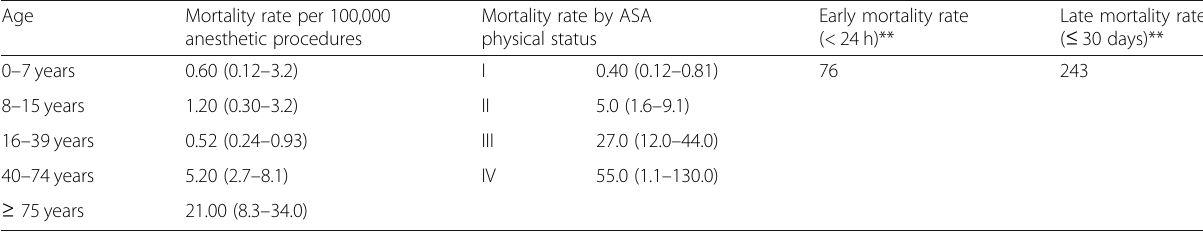
Table 2 Perioperative mortality rate according to time after surgical interval, age, and patients ’ ASA status